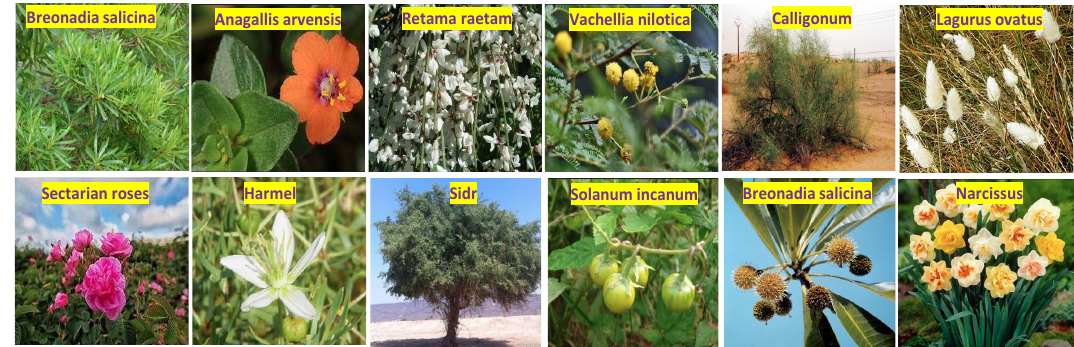
Figure 5. Some selected samples from our own data